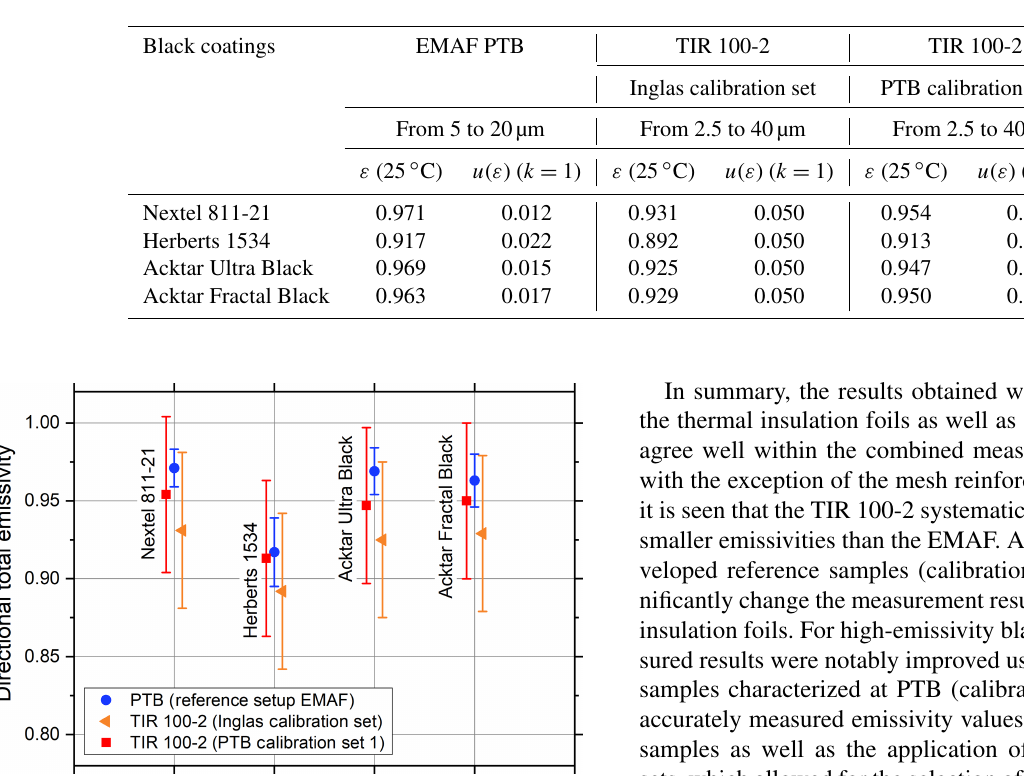
Table 7. The directional total emissivities and standard uncertainties of the four black coatings measured at the EMAF and measured using the TIR 100-2 with the two different calibration sets.